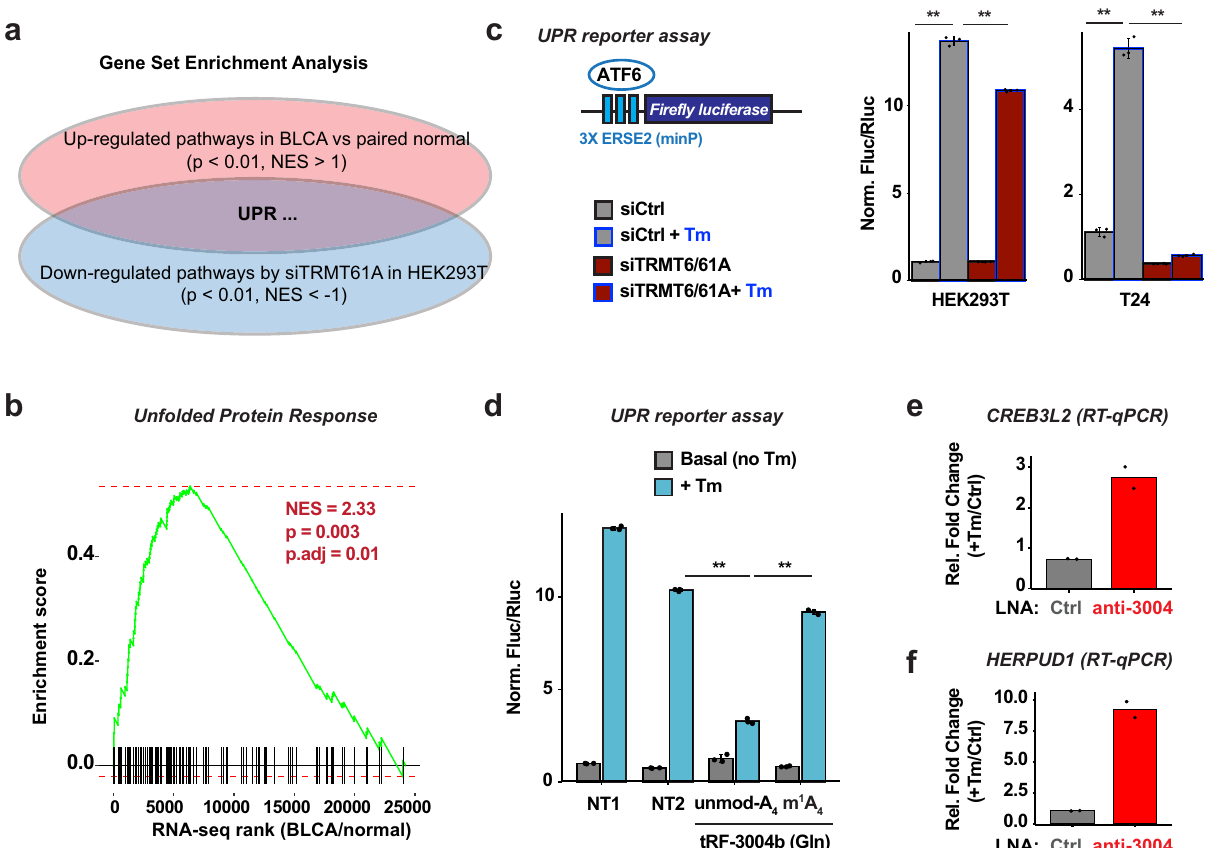
Fig. 8 tRF-3b modi fi cation by TRMT6/61A is important for maintaining the unfolded protein response. a GSEA from RNA-seq in BLCA and HEK293T siTRMT61A data reveals Unfolded Protein Response (UPR) as a candidate pathway regulated by TRMT6/61A. b Gene Set Enrichment Analysis shows UPR as positively enriched pathway in BLCA tumor compared to the paired normal samples ( n = 5, x -axis: ranking based on differential analysis from upregulated genes to downregulated genes). c TRMT6/61A regulates UPR response by UPR reporter assay in HEK293T and the BLCA tumor cell line T24. Three tandem repeats of ATF6 response element ERSE2 is inserted in the Fire fl y luciferase gene promoter. UPR response is measured by Fire fl y luciferase signals divided by Renilla luciferase signals (on co-transfected plasmid) and normalized to siCtrl basal level. Tunicamycin (Tm) is added to trigger UPR response. d m 1 A status on tRF-3 regulates UPR reporter output. tRF-3004b synthetic mimic and UPR reporter plasmid (same as above) are co-transfected into HEK293T. NT1 and NT2 are non-targeting control RNAs. e , f tRF-3004 targets have increased levels after tRF-3004 knock-down and tunicamycin treatment in HEK293T cells. Data are based on c , d n = 3 independent experiments, e , f n = 2 independent experiments. c , d Data represent mean ± SD, p value based on student ’ s t test (two-tailed paired sample, * p < 0.05, ** p < 0.01). Exact p values from left to right: c 0.00019, 0.00409, 0.00088,